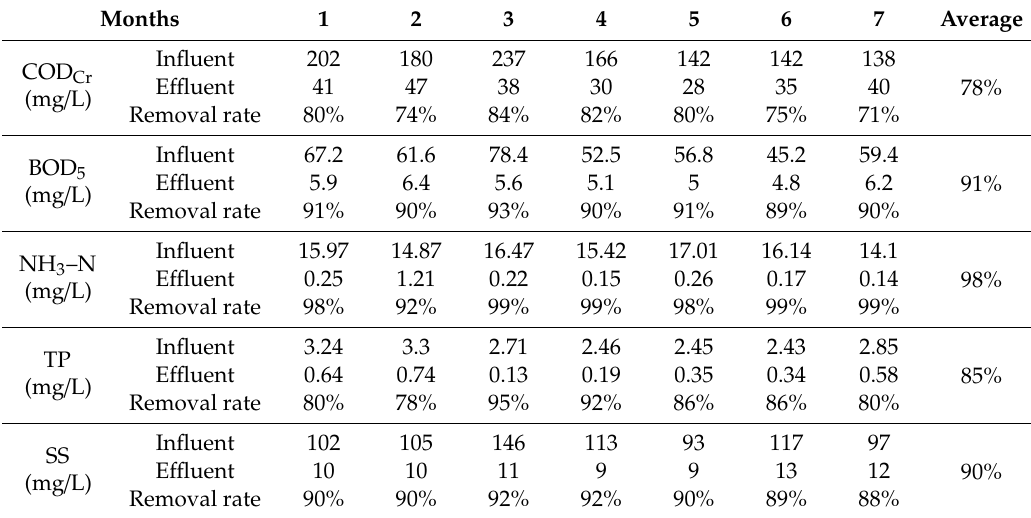
Table 3. Main pollutant indicators of the influent and e ffl uent from the wastewater treatment plant (WWTP) before renovation